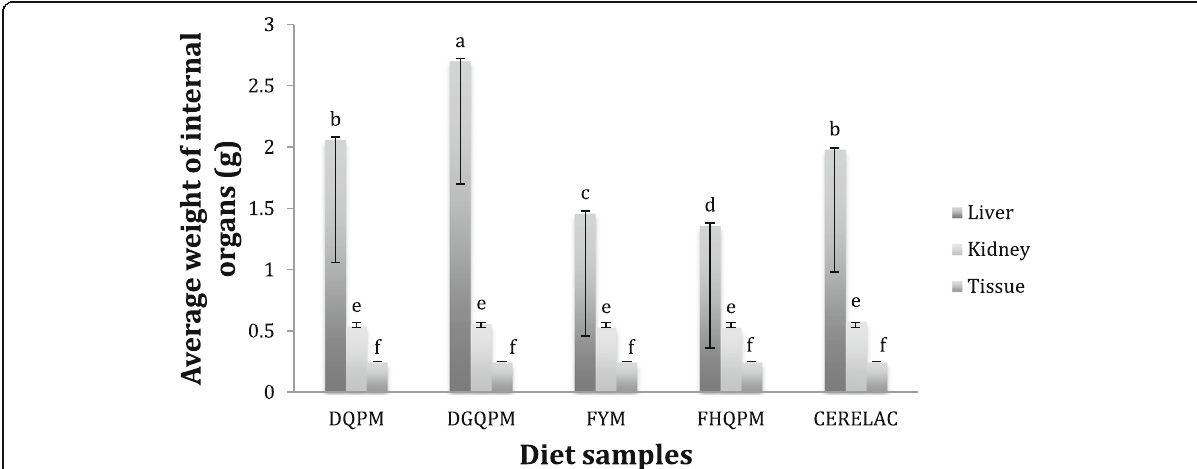
Fig. 2 Effect of the complementary diet on the internal organs development of the feeding animals. DQPM = Dried Quality Protein Maize, DGQP